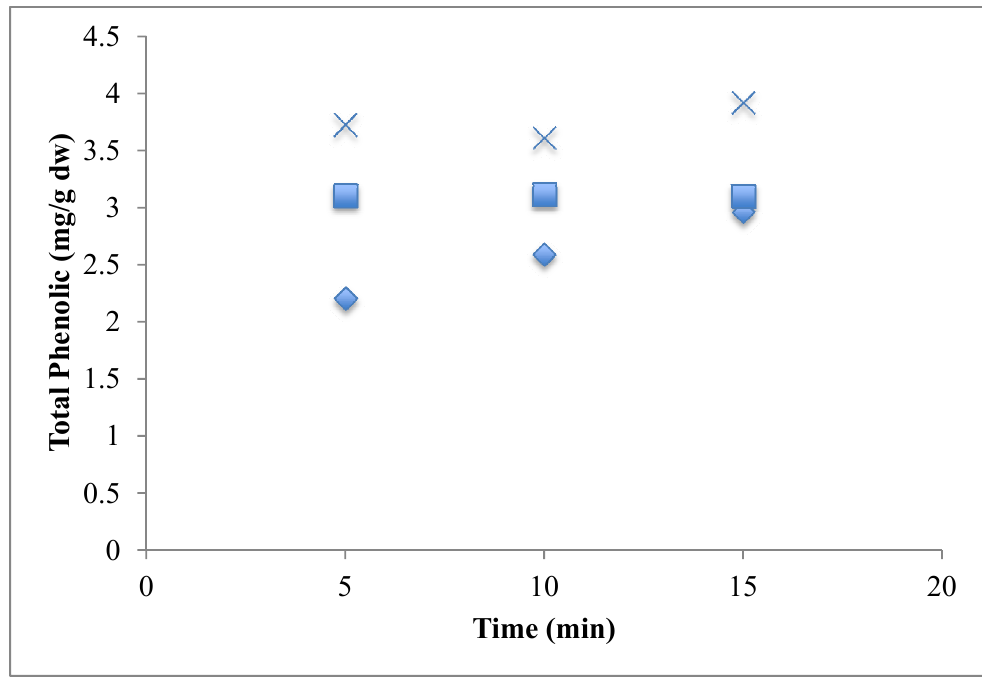
Figure 12. Effect of time and solvent concentration on total phenolic yield of the MAE